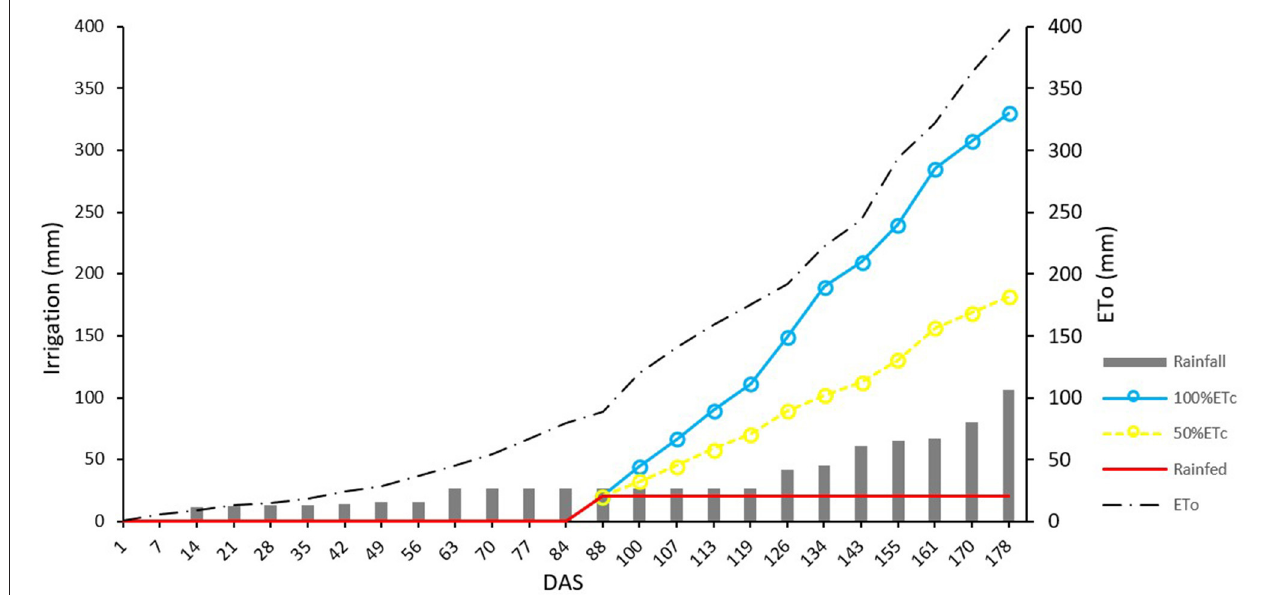
FIGURE 5 | Amount of water applied, rainfall, and reference evapotranspiration (ET 0 ) corresponding to the different irrigation treatments (100%ETc, 50%ETc, and rainfed) from March 2019 (87 DAS, days after sowing) to May 2020 (177